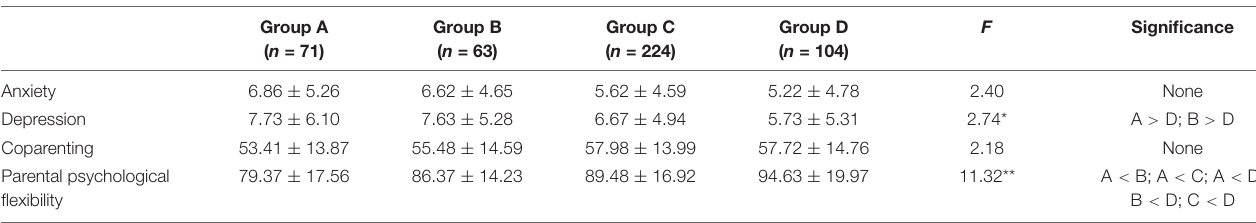
TABLE 3 | Comparisons in main study variables among parents with different educational